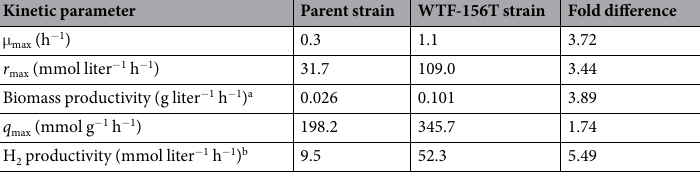
Kinetic parameter Parent strain WTF-156T strain Fold difference